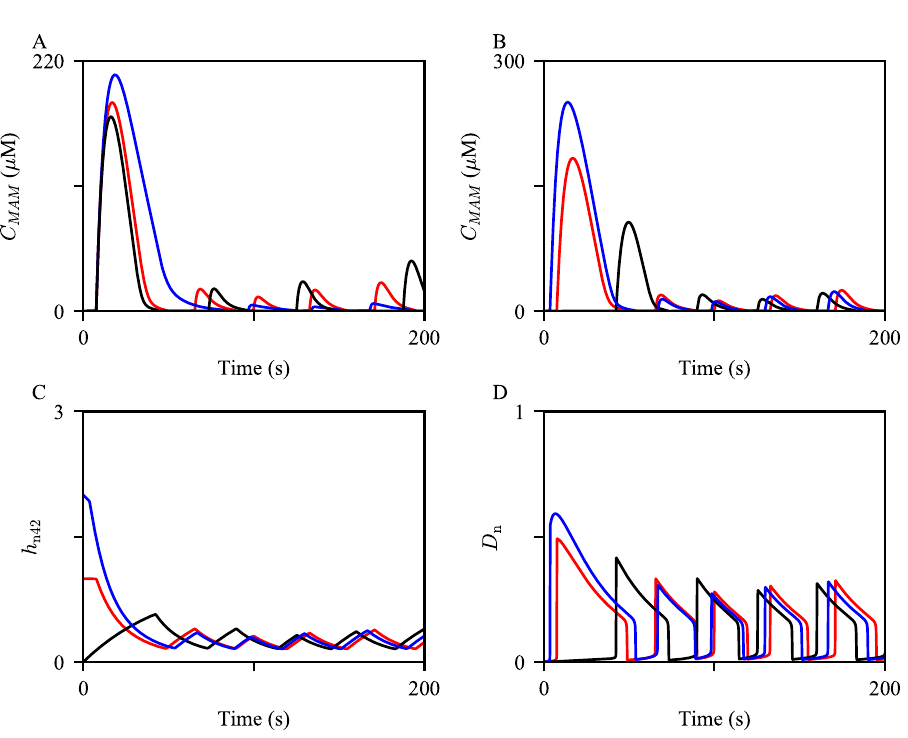
Fig 6. The first few MAM Ca 2+ spikes generated with varying H IPR and the initial condition of h n42 . (A) The oscillations were simulated with H = 0.05 (blue), 0.1 (red), and 0.15 (black). (B) The oscillations were simulated with IPR manually tuned h n42 (0) = 2 (blue) and 0 (black). The red trajectory is the control, simulated with the steady state initial condition, h n42 (0) = 0.99. (C) and (D) show the corresponding timeseries of h n42 and the fraction of MAM IPRs in the drive mode ( D n ), respectively, concurrently simulated with the trajectories shown in